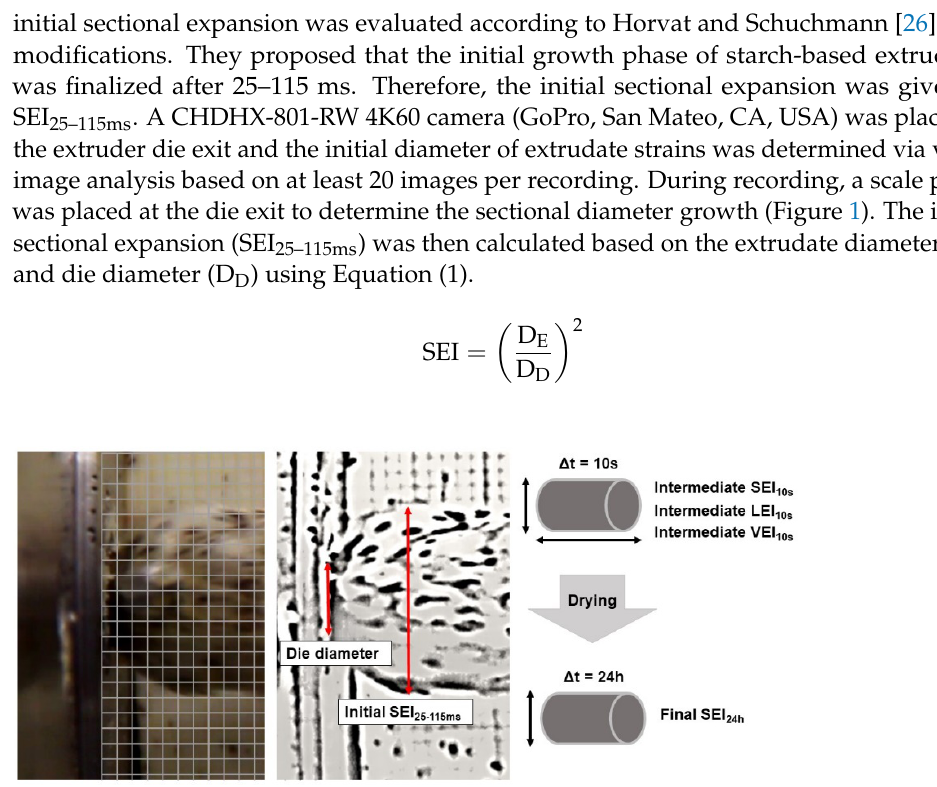
Figure 1. Representative image of extrudate expansion and the method used to determine expansion parameters.